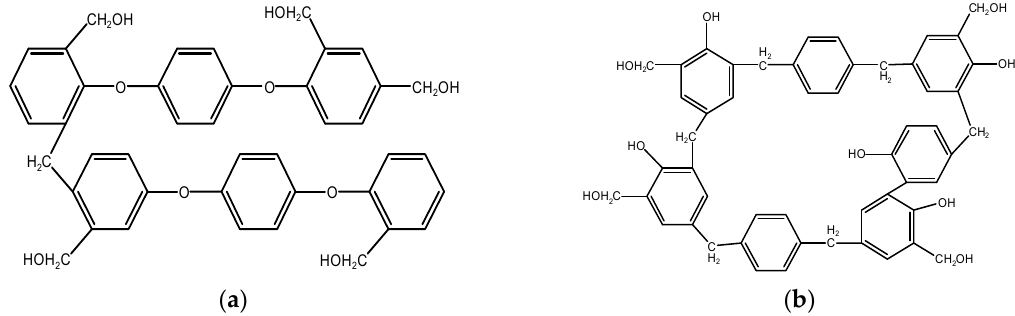
Figure 3. ( a ) Acid catalytic modification of phenolic resin; ( b ) base catalytic modification of phenolic resin.